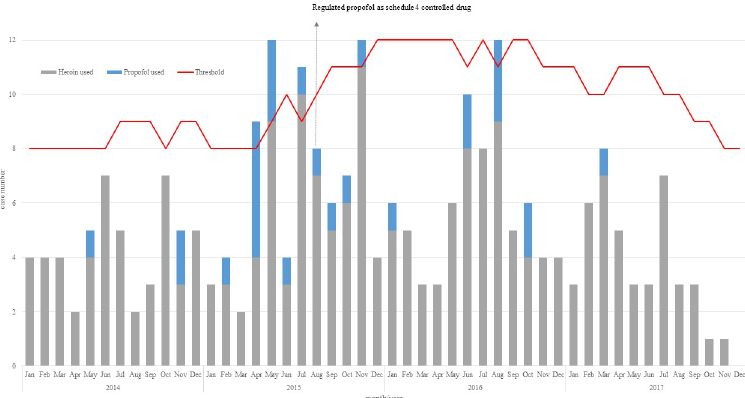
Fig 1. The temporal trend in PWID who were diagnosed HIV infection in 2014–2017 monitored by the Bayesian